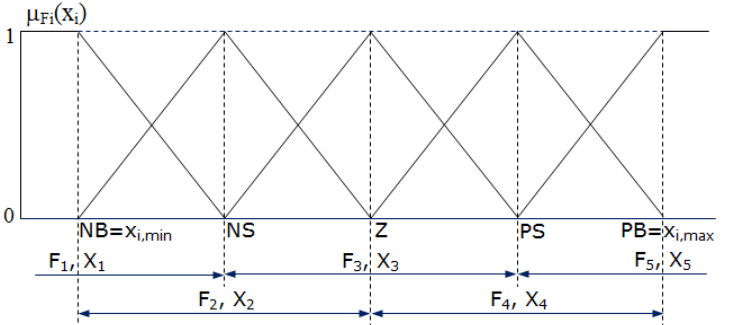
Figure 13. The membership function of position error, velocity error, and driving moment of joint i : x i ( x i = e i , e i , and U i